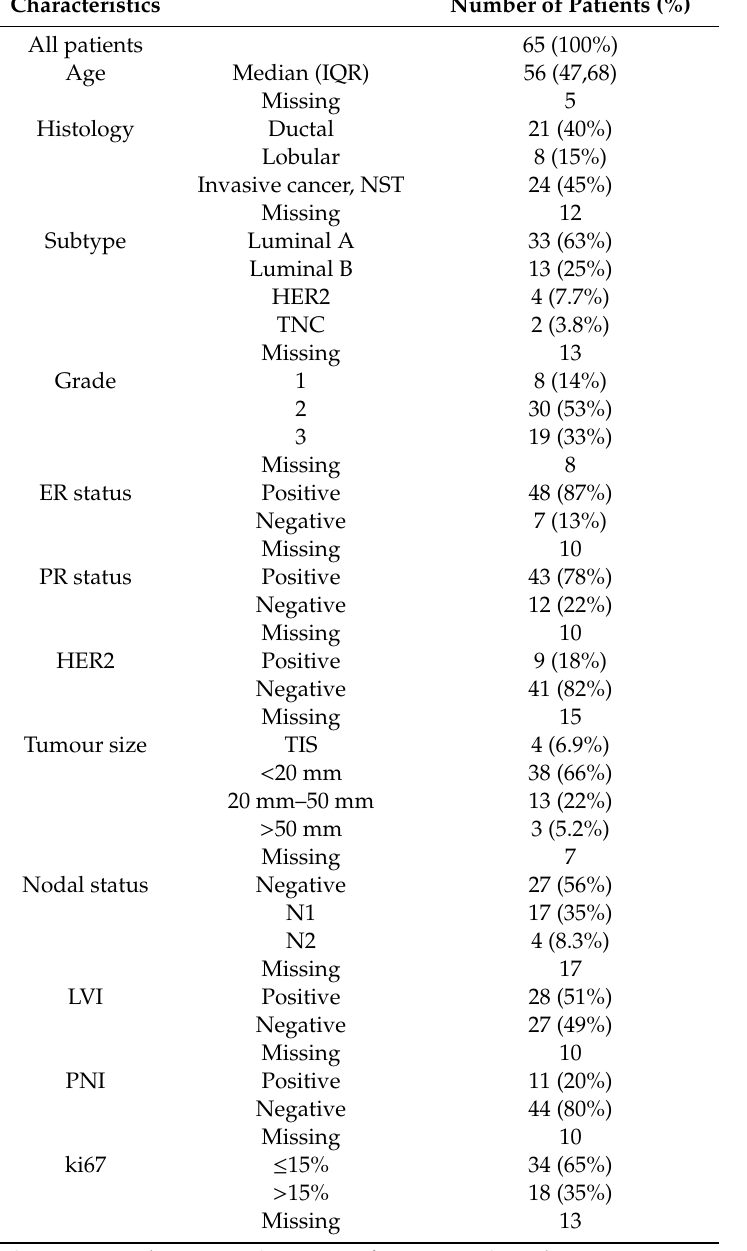
Table 1. Clinicopathological data of the included